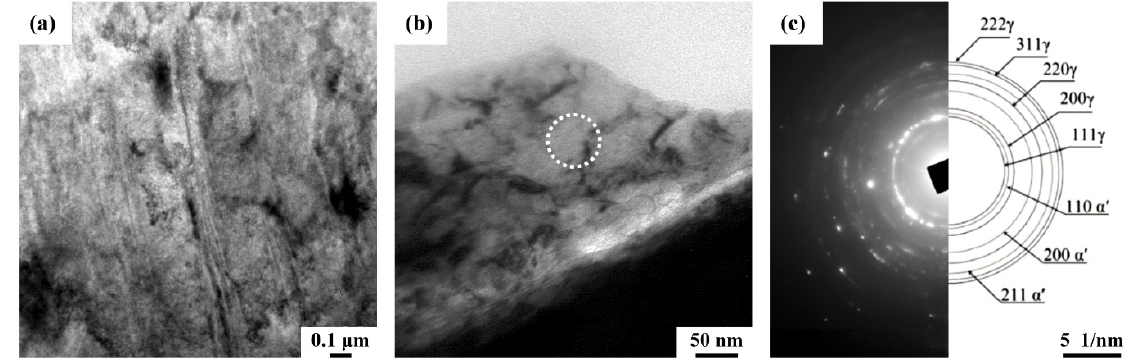
Figure 8. TEM images of the ( a ) shot-peened layer, ( b ) FIB sample and ( c ) the SADP of the sample in ( b ). The distribution of residual stress in the thickness direction from the shot-peened surface to the internal substrate is shown in Figure 9. Compressive residual stress above 600 MPa was found in the zone near the surface, and the peak residual stress was present in the sub-surface of the shot-peened sample. As shown in Figure 4, a deep drop in hardness occurred around the shot-peened surface, which meant only a very limited depth was affected by the cold work induced by micro-shot peening. The change in stress values in the residual stress profile was similar to that of the hardness profile of the shot-peened sample.